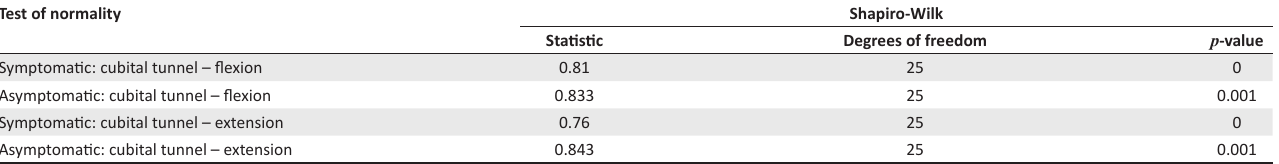
TABLE 1b: Comparison of ulnar nerve measurements in symptomatic versus contra-lateral elbow and asymptomatic participants at the level of the cubital tunnel. Test of normality